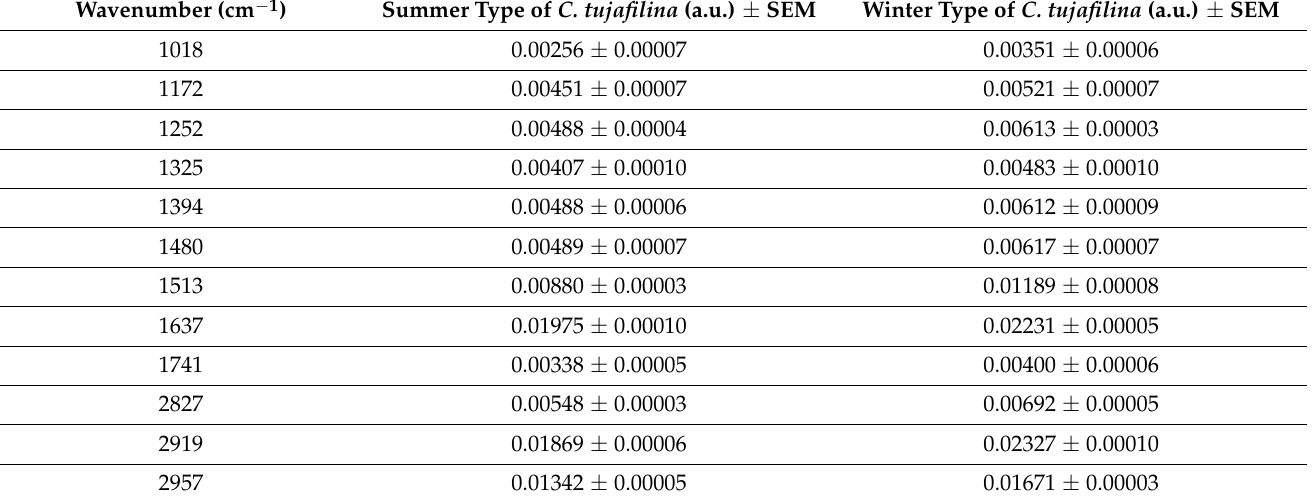
Table 1. Values of maximum absorbance analyzed for the summer and winter types of C. tujafilina . All the differences are statistically significant ( p < 0.05, Tukey’s test).